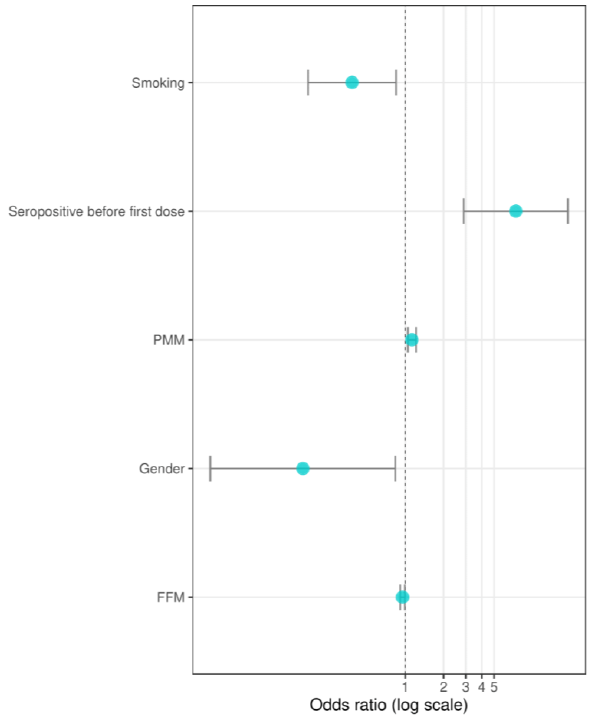
Figure 3. Association between selected parameters of IgG seropositivity. Odds ratio (OR) calculated with logistic regression. The figure presents the results as the mean ± 1.96 × standard error (95% confidence interval). Abbreviations: PMM — predicted muscle mass, FFM — fat-free mass.